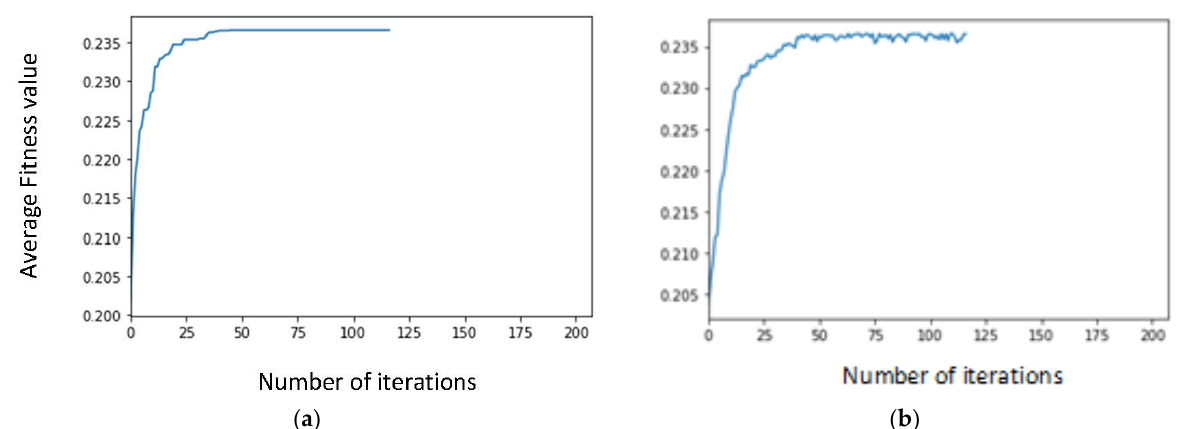
Figure 6 . Evolution of average fitness of ( a ) the best individual, ( b ) all the individuals, over the genetic loop, vs. number of iterations ‐ initial stop condition.